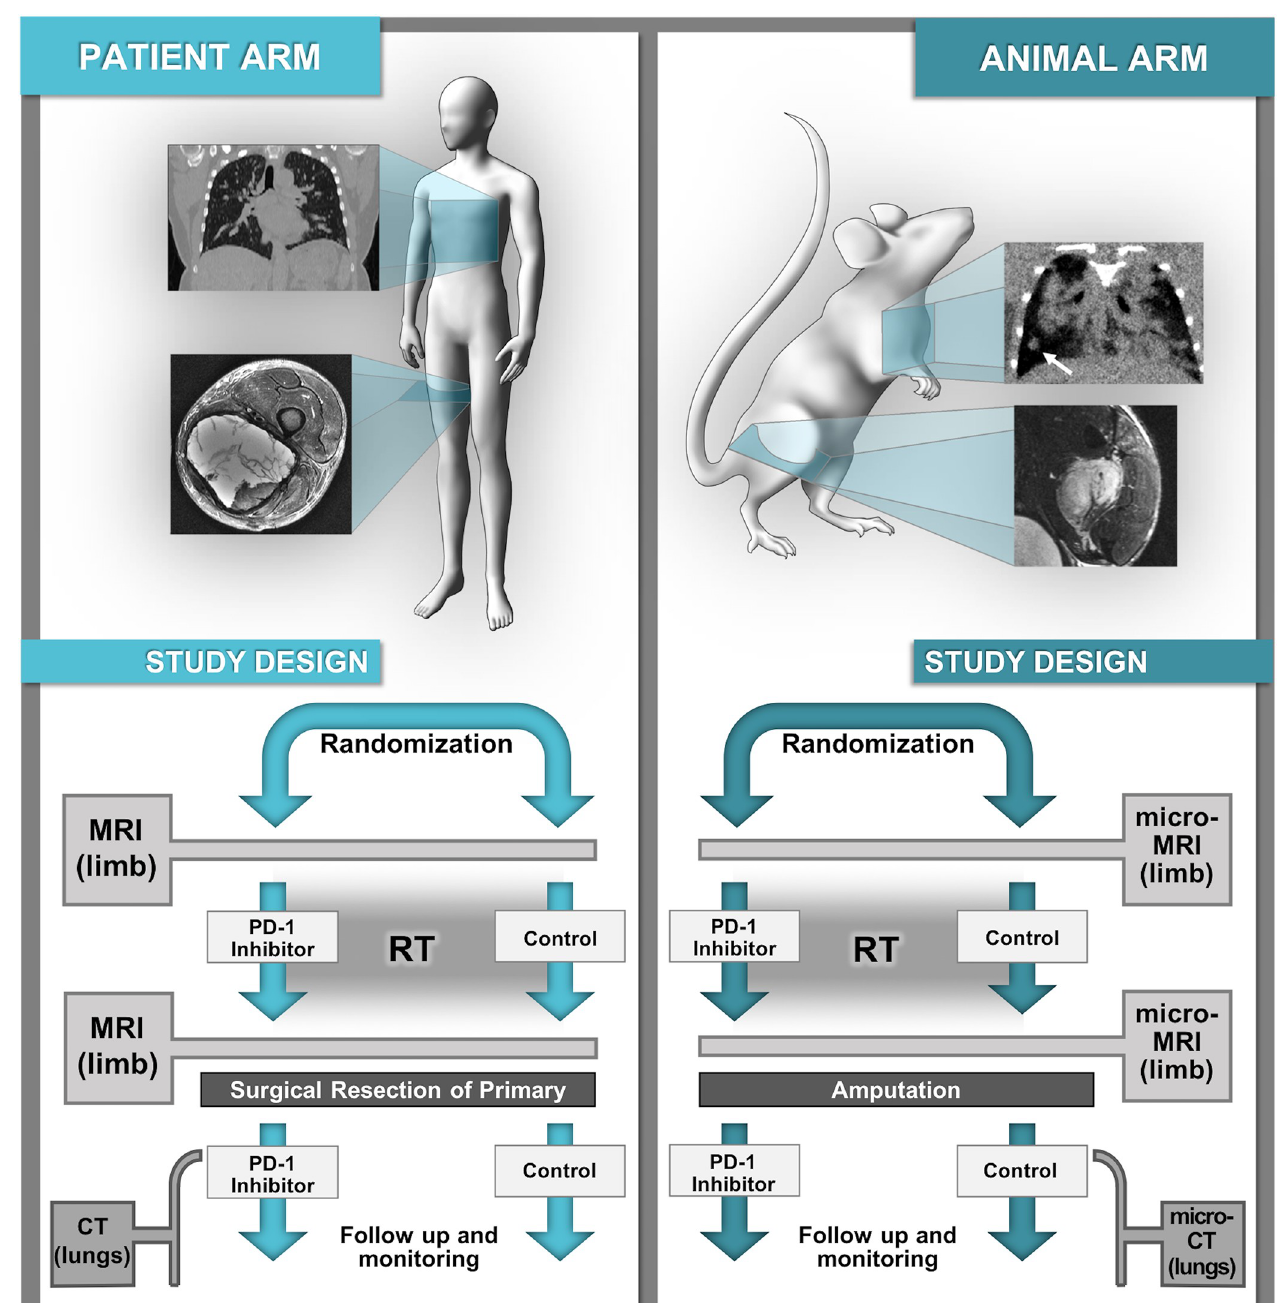
Fig 1. Schematic representation of a co-clinical trial which utilizes translational imaging. Flow charts describing the clinical (A) and preclinical (B) sections of a co-clinical trial of RT with or without the addition of PD-1 inhibition in soft tissue sarcoma. Treatment dosing and imaging procedures in the preclinical arm have been designed to mimic the clinical trial as closely as